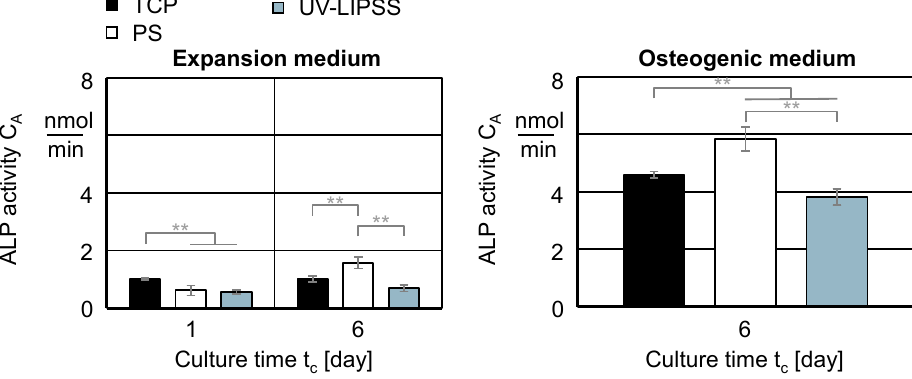
Figure 9. Cell ALP activity C A on TCP, PO, and UV-LIPSS. Statistical analysis by ANOVA and Tukey’s test for the determination of statistically significant differences (n = 5 each group, ** for p < 0.01).